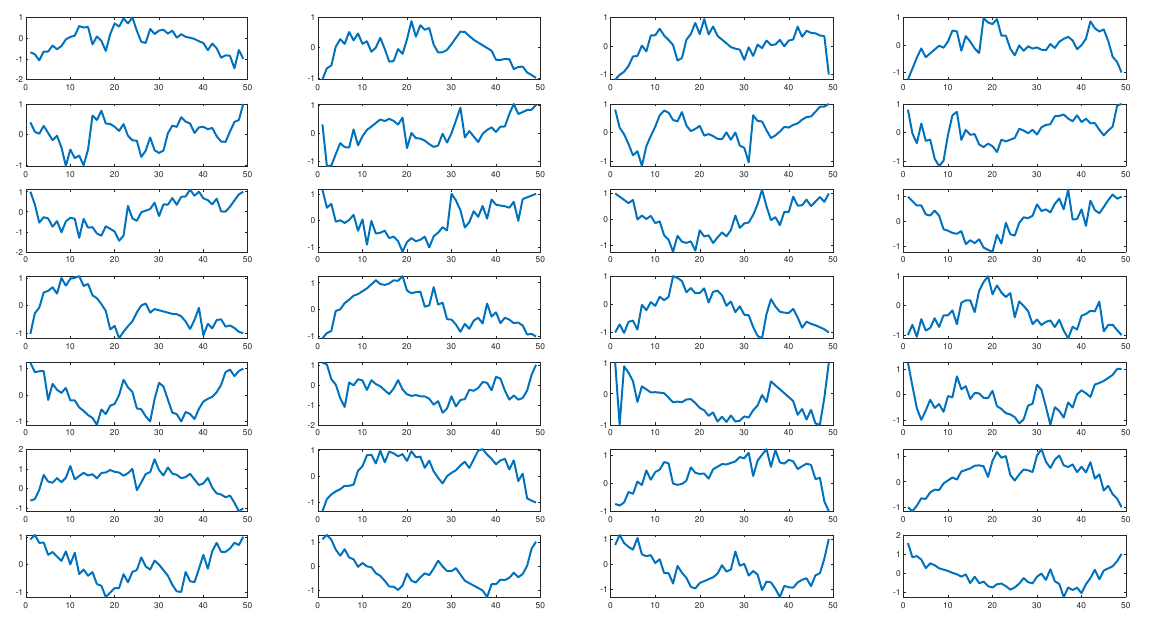
Figure 9. Synthetic data of the 11 template patterns. The first 4 samples of 7 templates are shown. Table 2. The overall accuracy of each model on the synthetic data.